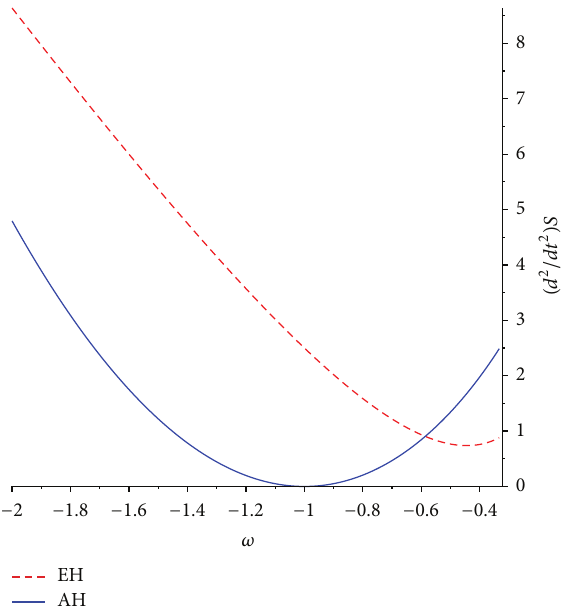
Figure 2: TE for RSII brane for perfect fluid with constant equation of